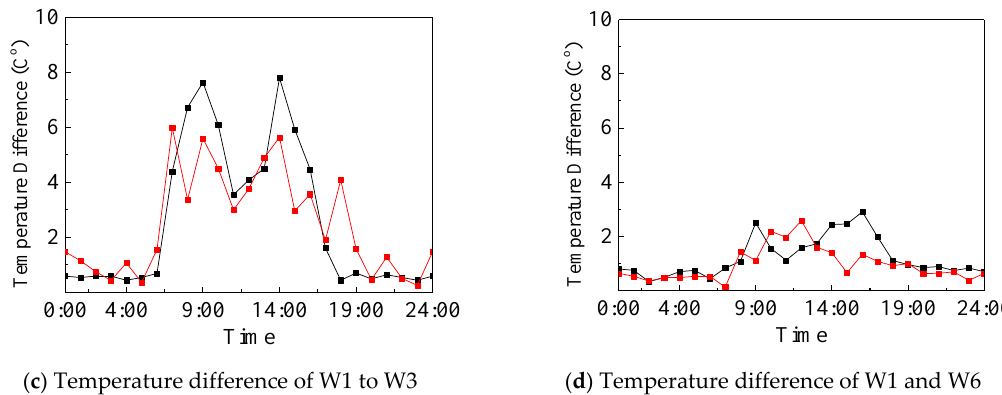
Figure 6. All-day temperature difference variation curves of various members. Red and black lines indicate the top and bottom test points, respectively.